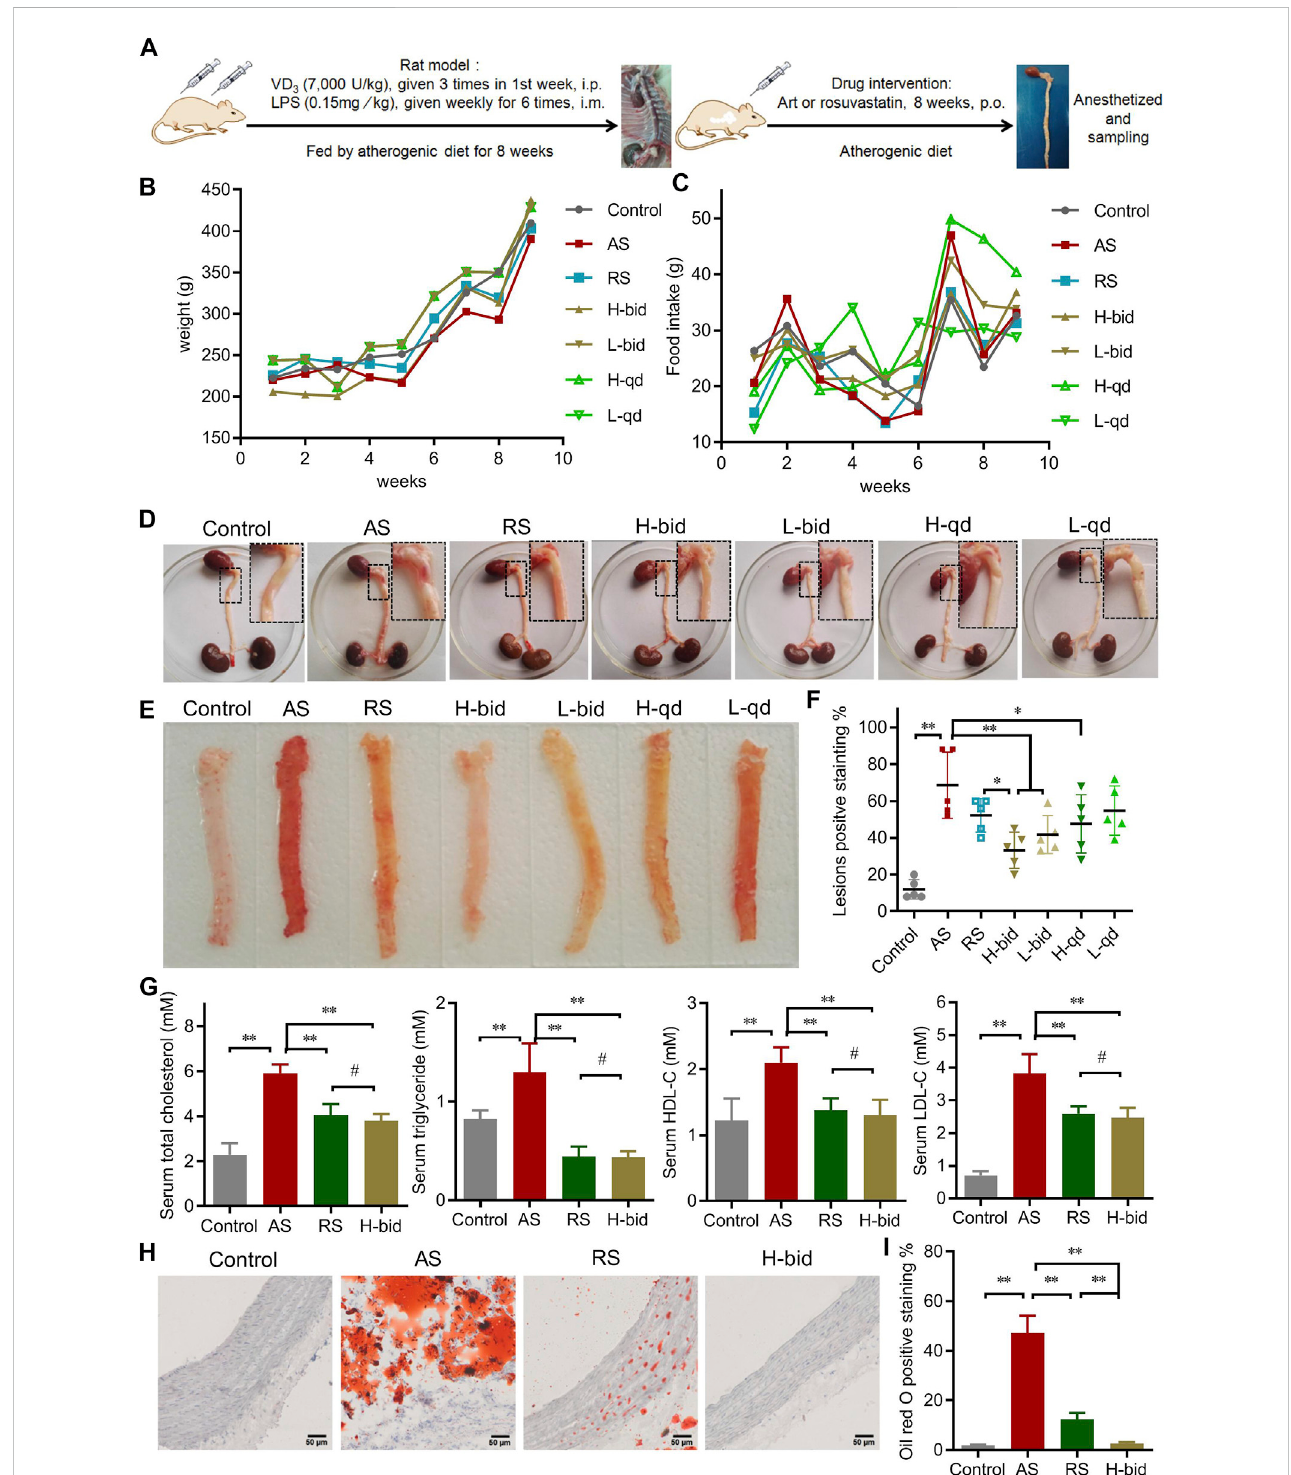
FIGURE 1 Art ameliorates AS in atherogenic diet – LPS-induced rats. (A) Procedure of the animal experiments. (B) Body weight of AS rats ( n = 10). (C) Feed intake of AS rats ( n = 10). (D) General observation of the heart and entire aorta. (E – F) Oil red O staining of aortas ( n = 5). (G) Serum level of lipids ( n = 5). (H – I) Oil red O staining of arterial sections. Paraf fi n sections were stained using Oil red O and then observed under a light microscope (Bar = 50 μ m). The bar graph shows lesion-positive staining % ( n = 5). * p < 0.05; ** p < 0.01; # p >